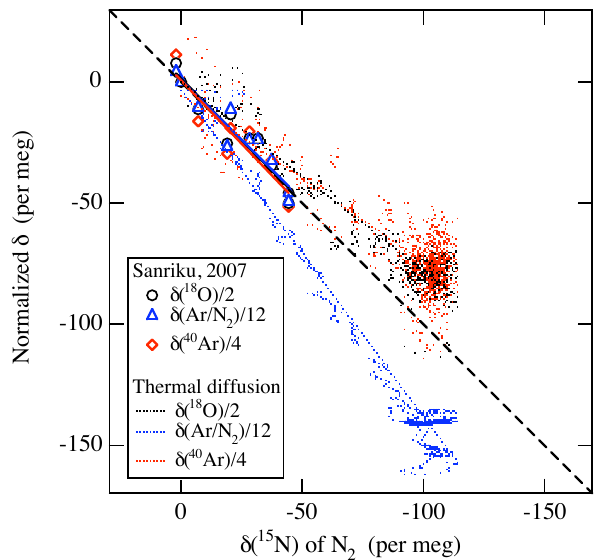
Figure 2. Plots of δ ( 18 O)/2, δ (Ar/N 2 )/12 and δ ( 40 Ar)/4 against δ ( 15 N) for stratospheric air 2 Fig. 2. Plots of δ ( 18 O)/2, δ (Ar/N 2 )/12 and δ ( 40 Ar)/4 against δ ( 15 N) samples collected over Sanriku, Japan on July 4, 2007, and those for laboratory 3 for stratospheric air samples collected over Sanriku, Japan, on 4 July experiments to examine a possible effect of thermal diffusion at the air intake of the 4 2007, and those for laboratory experiments to examine a possible sampler on the collected air samples (see text). Black dashed line represents the 5 relationship expected from the gravitational separation. 6 effect of thermal diffusion at the air intake of the sampler on the 7 collected air samples (see text). Black dashed line represents the relationship expected from the gravitational